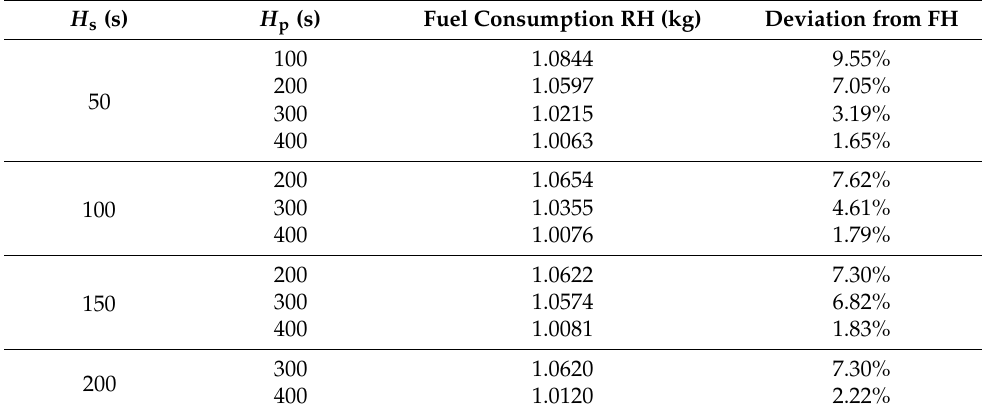
Table 1. Fuel consumption results achieved with RH-based EMS compared with the FH approach with different H s and H p